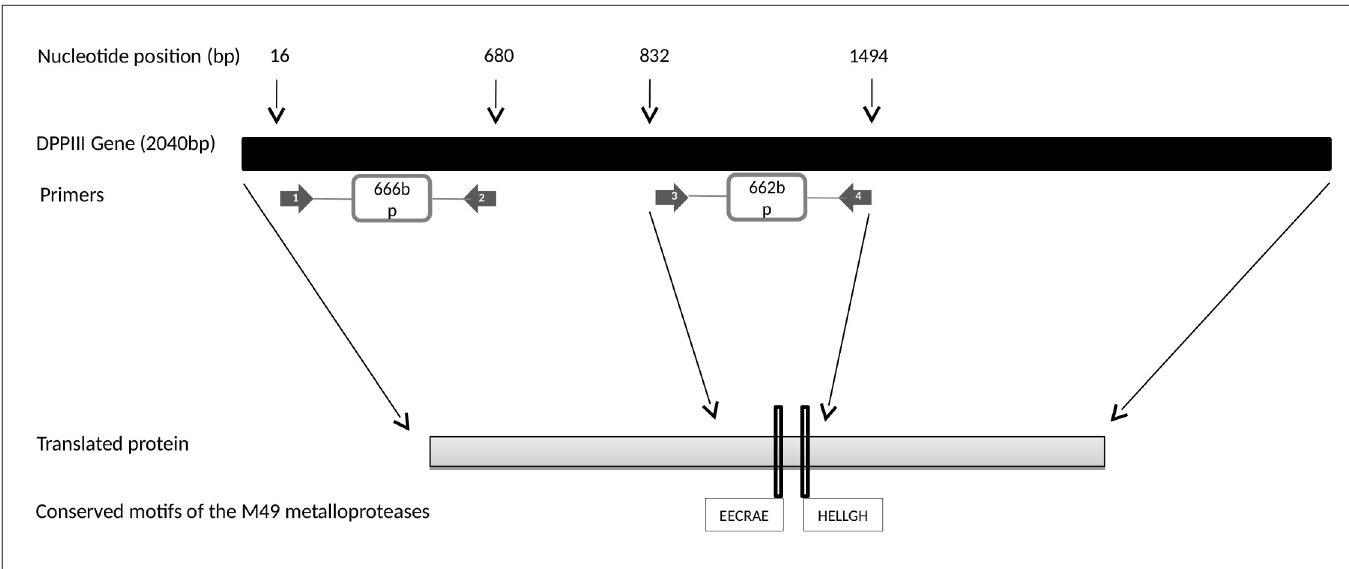
Fig 1. Schematic representation of the DPPIII gene and PCR primers positions. 1 & 2: Primers used by [53] (DPP F/DPP R). 3 & 4: Primers designed in this study ( DPPIII -F/ DPPIII -R) amplify a 662bp fragment.